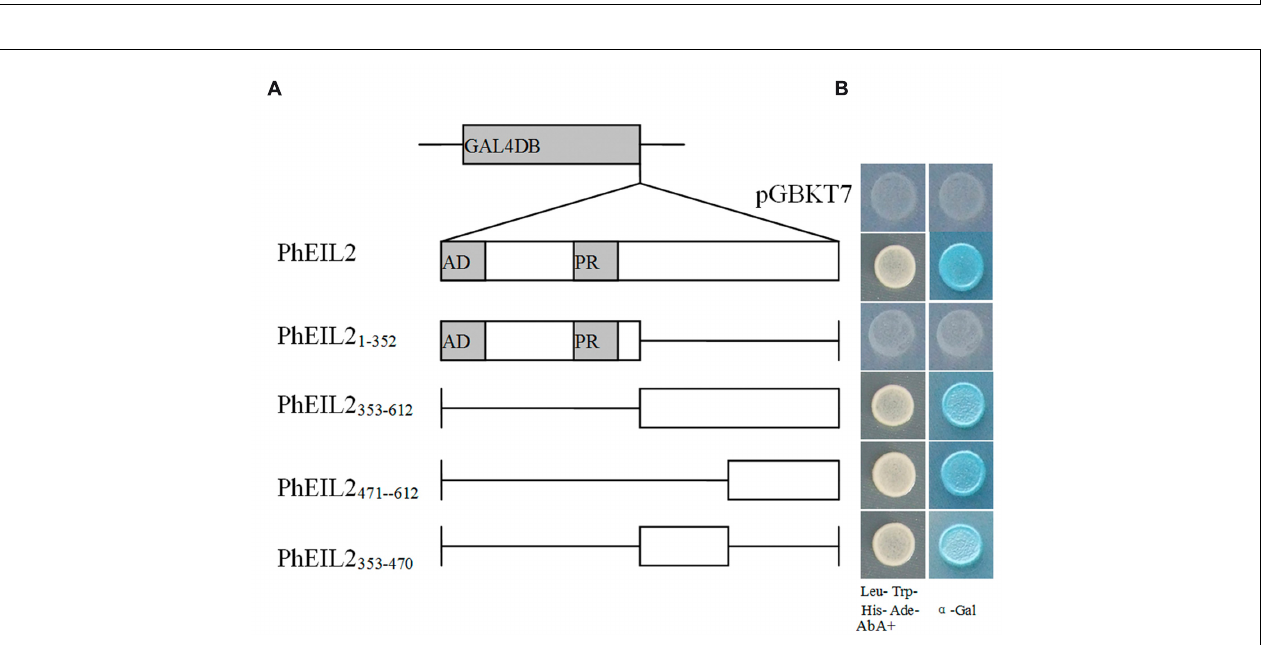
FIGURE 6 | GAL4 DB-PhEIL2 fusions and their effect on transcriptional activation of the lacZ reporter gene in yeast cells. (A) Schematic overview of the fusion proteins between the GAL4 DNA-binding domain (DB) and various deletion mutants of PhEIL2 that were investigated for transcription-stimulating activity in yeast. (B) The PhEIL2 and its deletion constructs fused in the GAL4 DB expression vector were transformed into yeast strain Y2HGold. The transformants were selected by growth on Trp- and Leu- medium at 30 ◦ C for 3 days. Yeast transformants were tested for growth in the absence of His, Trp, Leu, and Ade but containing 125 µ M Aureobasidin A as well as turn blue in the presence of the chromagenic substrate X- β -Gal was scored as a positive interaction. The yeast strain is carrying a modified HIS gene whose transcription is under the control of GAL4 operator.